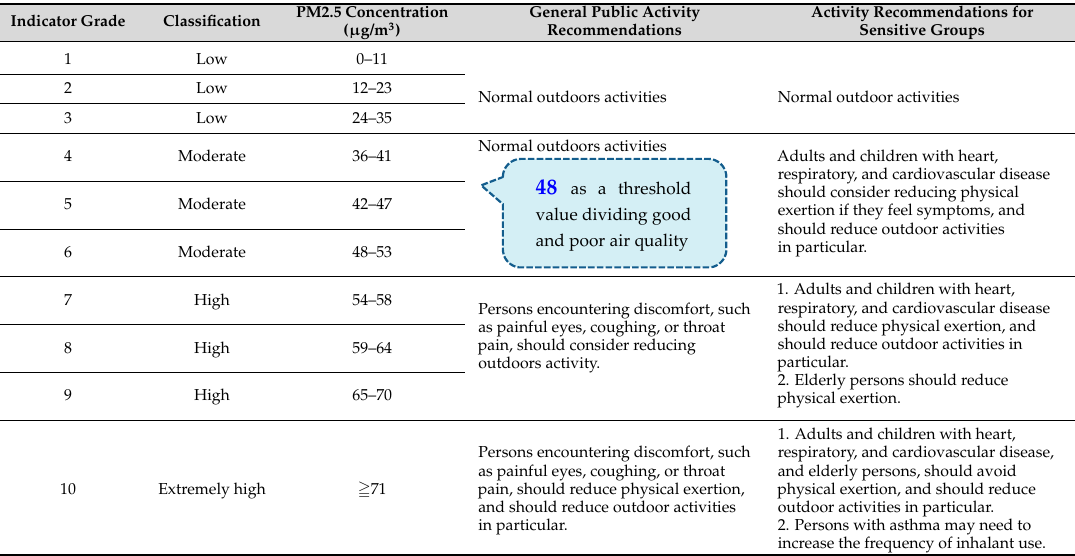
Table 1. Fine particulate matter (PM 2.5 ) indicator values and activity recommendations [30].